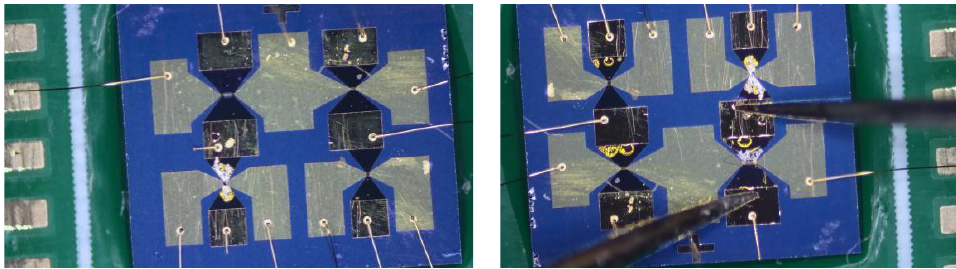
Figure 15. Circular level test results of different sizes .